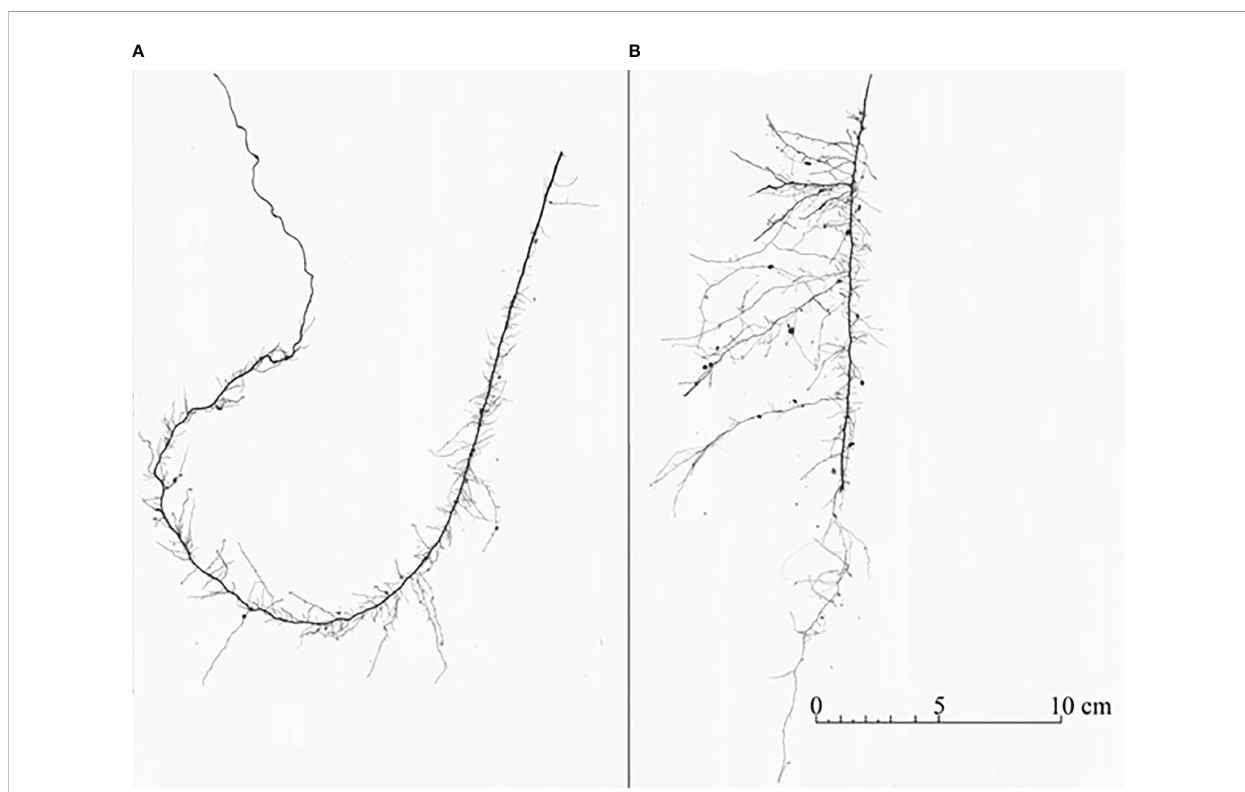
FIGURE 2 Roots from resource-partitioned treatment growing with high water (A) and nutrient (B) availability from the same individual of P. virgatum . Roots acquiring only water (A) typically exhibited greater elongation of primary roots and reduced development of lateral branches relative to roots growing with nutrients (B)